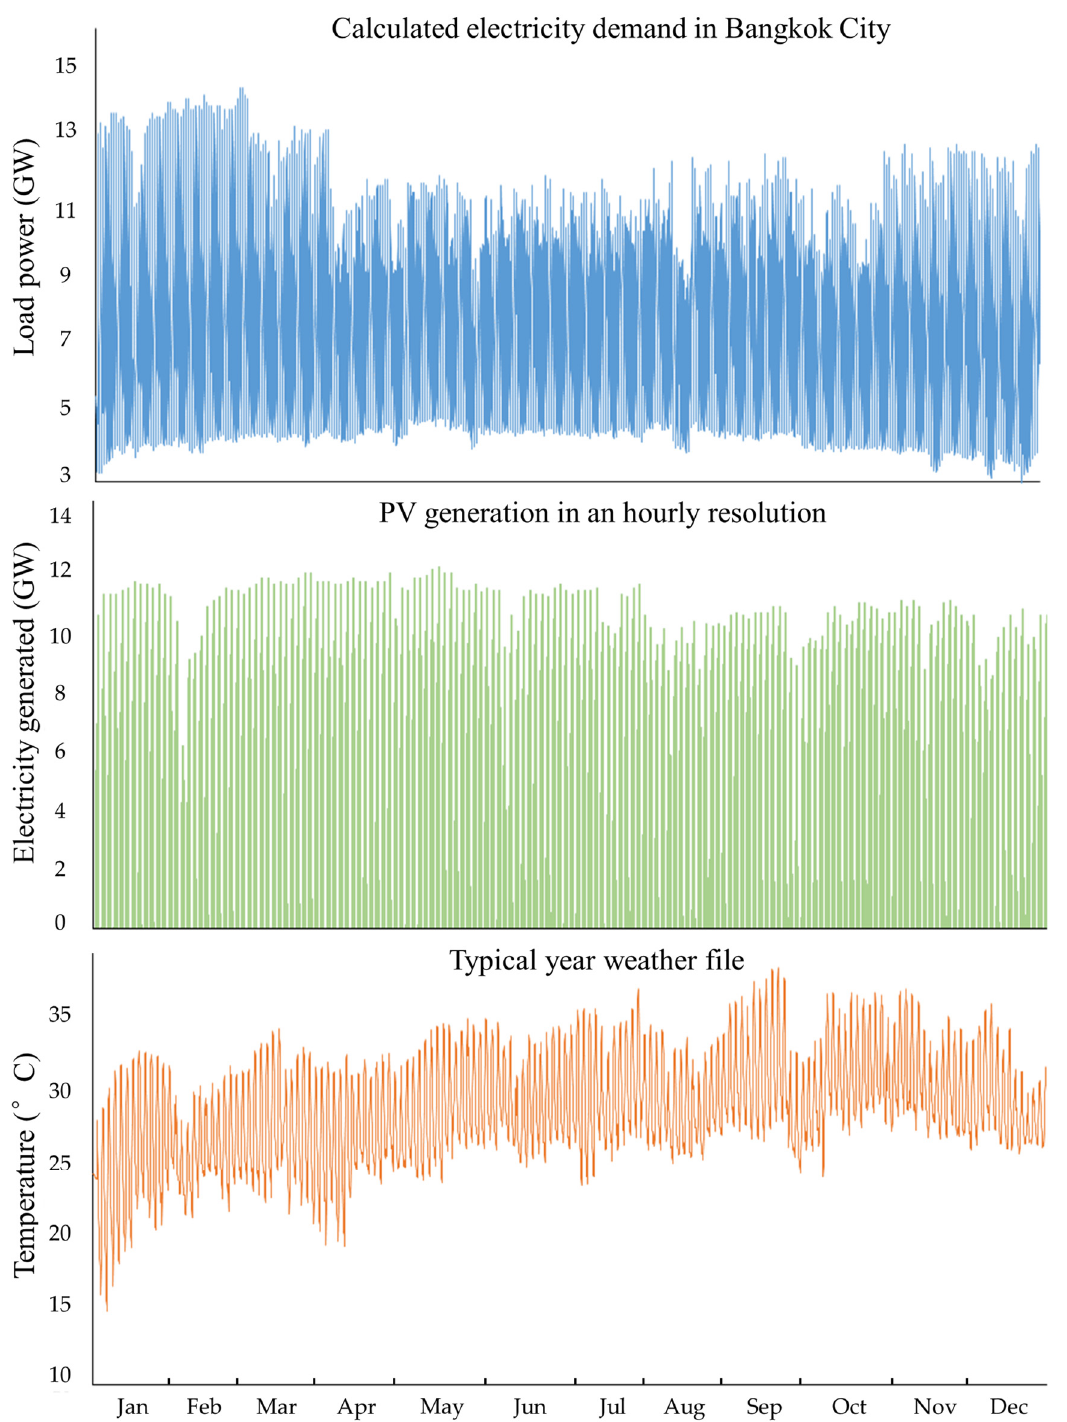
Figure 2. Temperature, electricity demand, and PV generation at an hourly resolution in Bangkok City. Data for demand and PV generation were calculated using SAM, according to the typical year’s weather file.